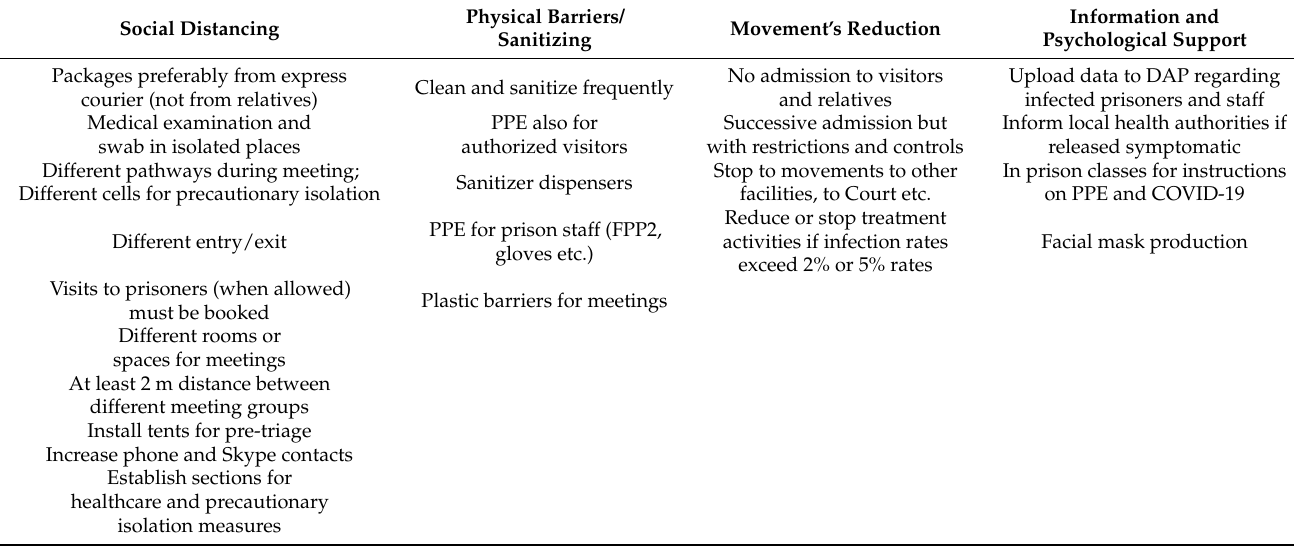
Table 1. Summary list of actions taken by the Italian Prison